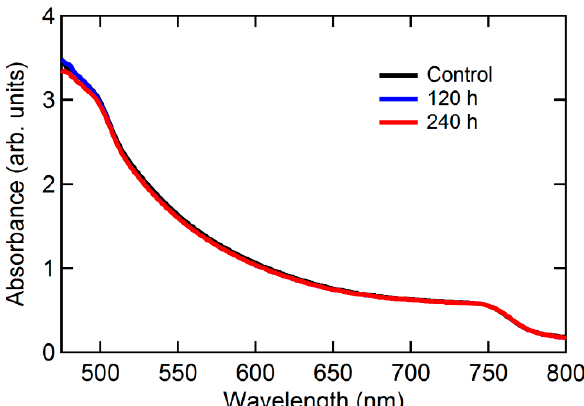
Figure 2. The UV-vis absorbance spectrum for control, 120 h and 240 h degraded perovskite films. Perovskite films were deposited on the PEDOT:PSS coated substrates.